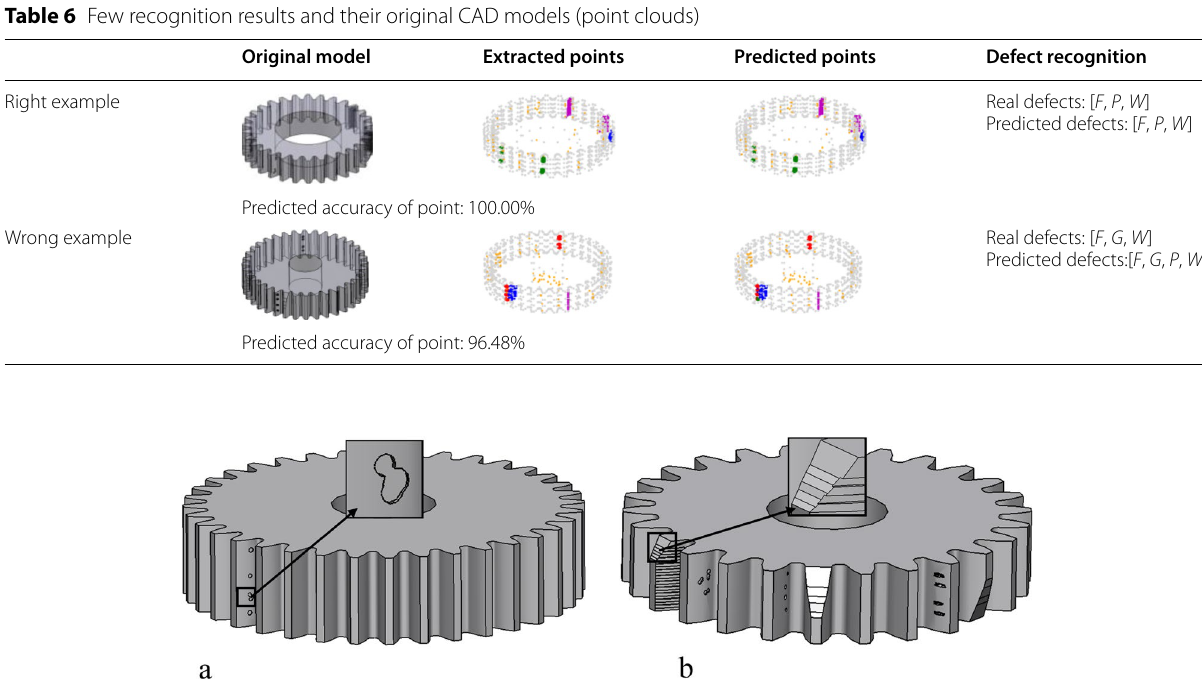
Fig. 13 Gear models with intersecting defects. a Intersection result of pitting holes; b Intersection result of broken tooth and